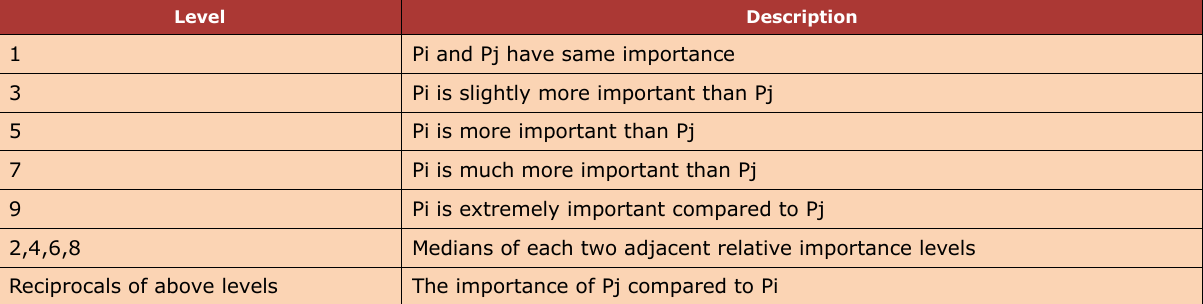
Table 2. Descriptions of Levels of Relative